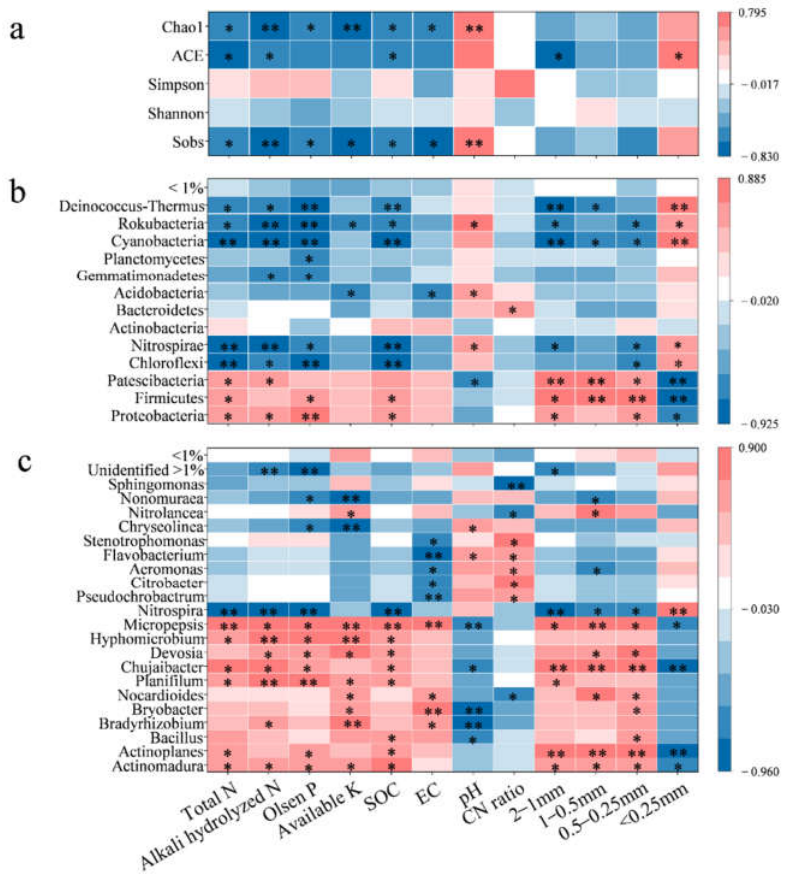
Figure 4. Spearman correlation analysis between soil properties and bacterial diversity ( a ) and composition (on phylum ( b ) and genus ( c ) levels). * indicates significant correlation at p < 0.05, while ** indicates extremely significant correlation at p < 0.01.